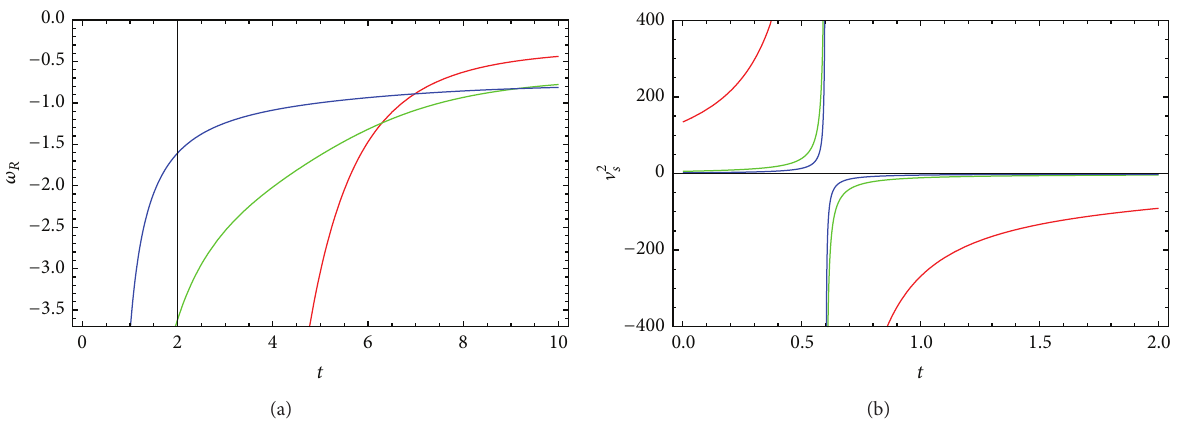
Figure 1: Plots of (a) effective EoS parameter and (b) squared speed of sound versus cosmic time 𝑡 , for 𝑛 = 1 (red), 𝑛 = 2 (green), and 𝑛 = 3